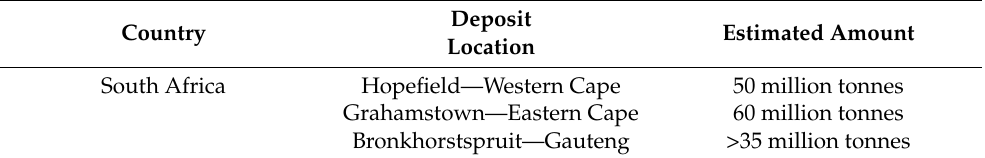
Table 1. Selected kaolinite clay deposits in South Africa